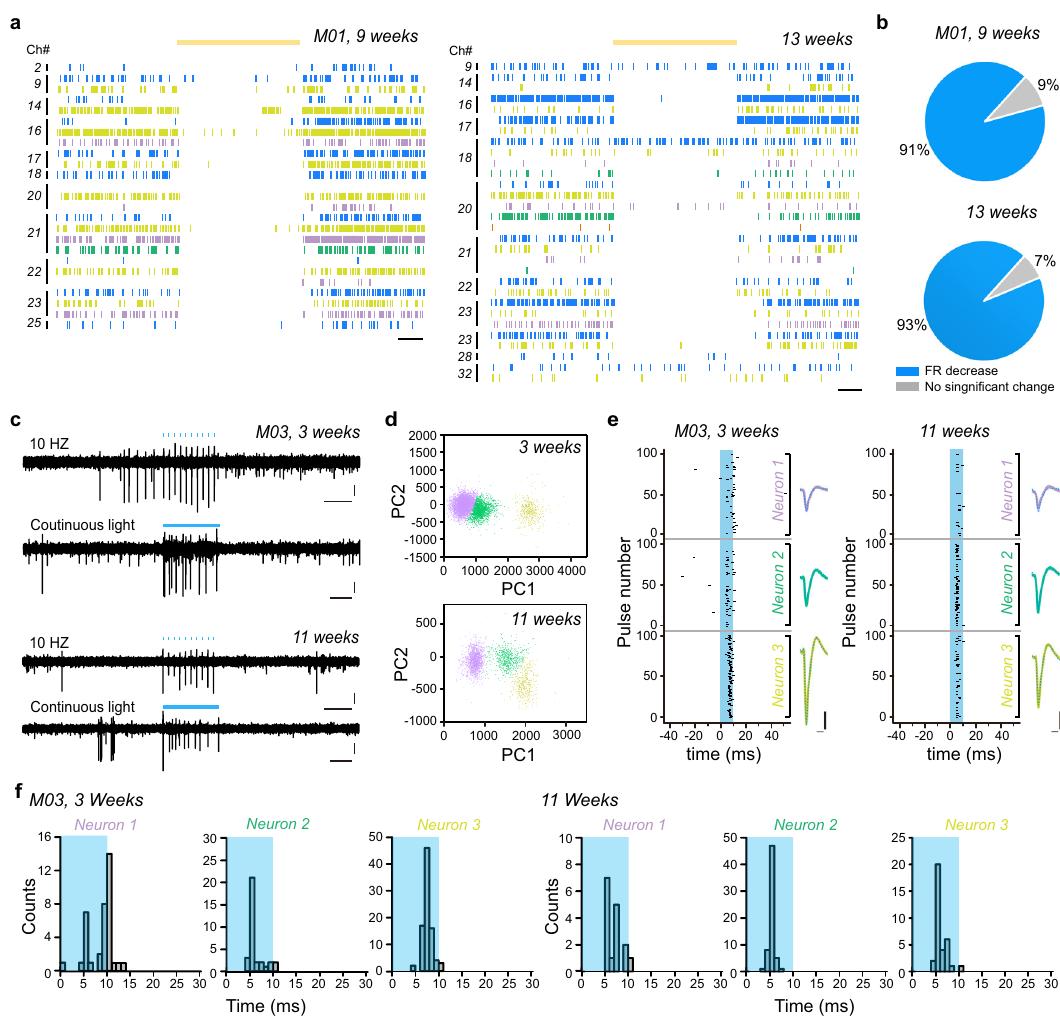
Fig. 4 Long-term optogenetic stimulation and electrical recording. a Spike rasters of neurons recorded by an AAV9-hSyn::eNpHR3.0-delivery optrode implanted in mouse M01 during 10-s, 2-mW/mm 2 yellow light stimulation at 9 (left) and 13 weeks (right) after implantation, respectively. Scale bar, 2 s. b Percentage of neurons with different responses in fi ring rates during 2-mW/mm 2 yellow light stimulation at 9 (up, 25 neurons) and 13 weeks (down, 30 neurons) after implantation, respectively. c Example AP traces in response to 10 Hz, 10-ms blue light pulses, and 0.5-s continuous illumination at 3 and 11 weeks after implantation. The traces were recorded by a microelectrode channel (Ch24) of an AAV9-hSyn::ChR2-mCherry-delivery optrode implanted in the M2/VO cortex of mouse M03. Light stimuli are indicated by blue bars, and the power density was 20 mW/mm 2 . Scale bar, 50 μ V (vertical). d Principal component analysis (PCA) of sorted waveforms. e Raster plots showing the spiking times of recorded neurons relative to the onset of each 10-ms light pulse during 10 Hz stimulation at 3 and 11 weeks after implantation, respectively. Scale bar, 0.5 ms (horizontal) and 50 μ V (vertical). f Latency between the light onset and the fi rst spike at 3 and 11 weeks after implantation. Blue boxes indicate the 10-ms laser